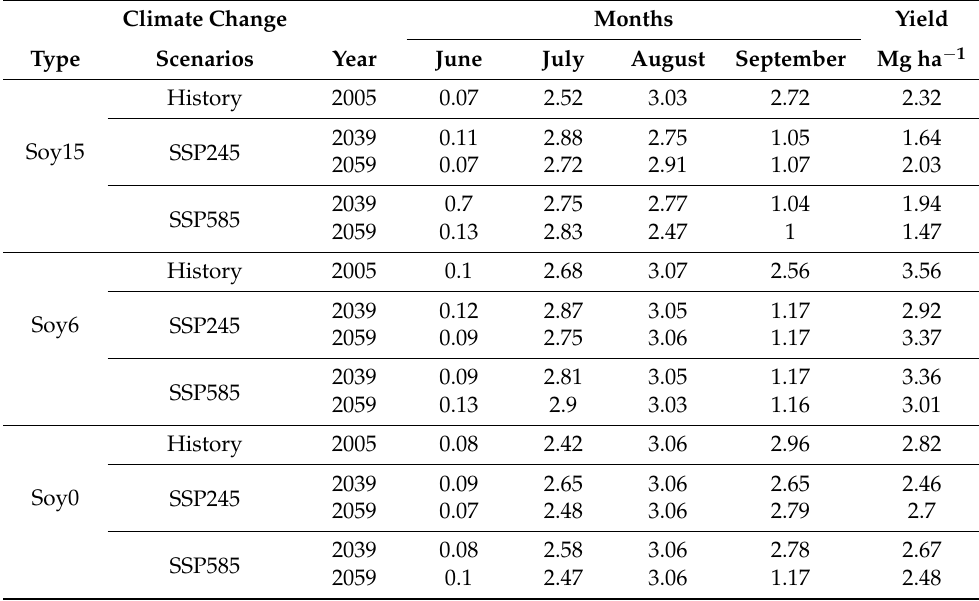
Table 10. Leaf area index (LAI) developments for Soy15, Soy6, and Soy 0 cultivars in 2005 and future (2039 and 2059) under two climate change scenarios (SSP245 and SSP585). Climate Change